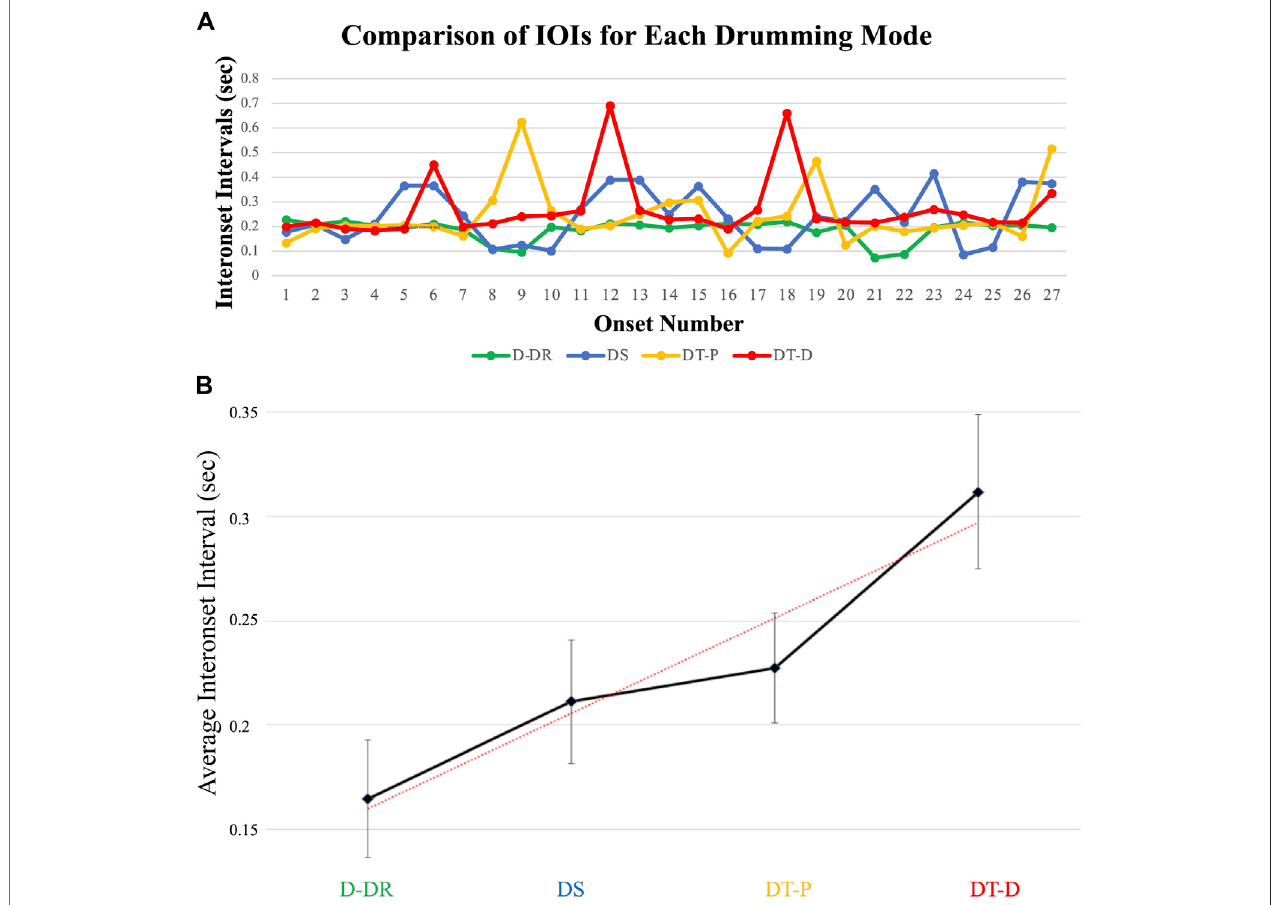
FIGURE 7 | A comparison of IOIs in seconds for representative samples of the four drumming modes. (A) Top graph illustrates the temporal IOI pattern for each sample (see sound samples Supplementary Samples 4A – D ). (B) The bottom graph summarizes the average IOIs across all samples for each drumming mode (with error bars indicating ± 2 SE). Note the increase in average duration length as samples move from musical rhythms (D-DR, sound sample Supplementary Samples 4A ) towards the direct imitation of speech (DT-D, sound sample 4d) where more speechlike constraints are introduced to drumming rhythms. Dotted line illustrates a signi fi cant linear